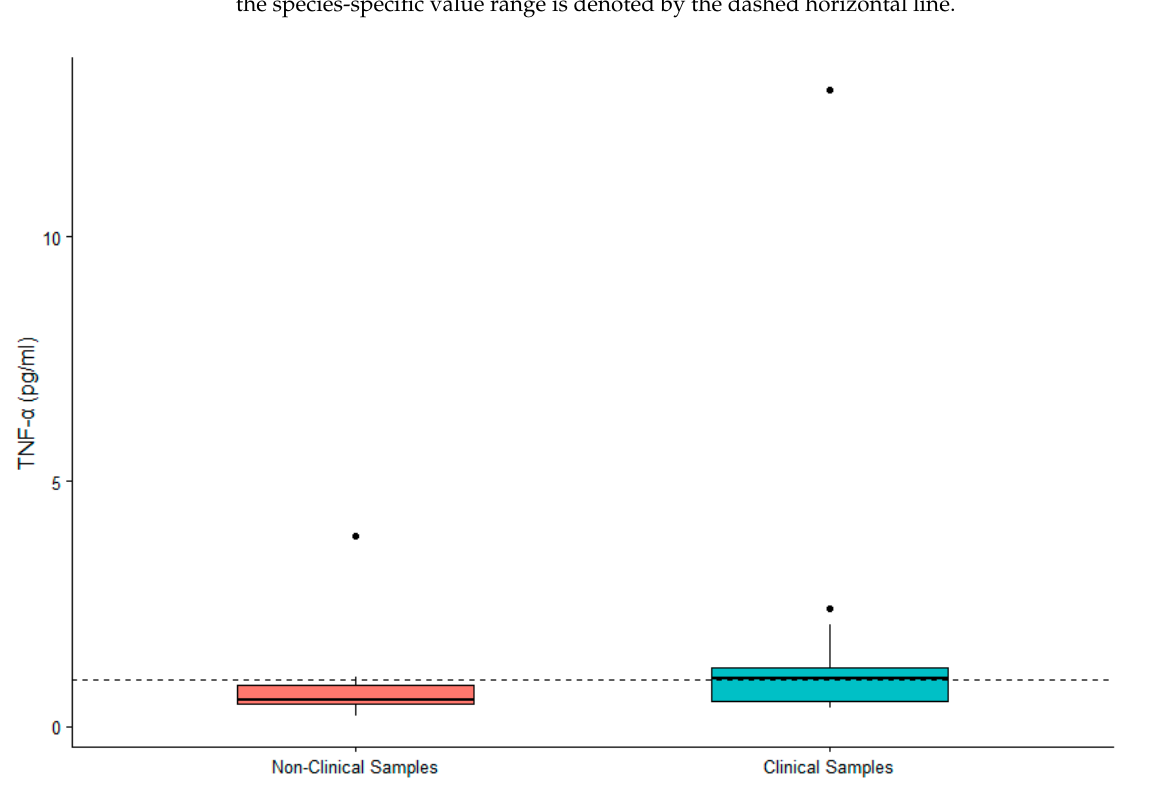
Figure 3. Differences in concentrations of serum TNF ‐α between non ‐ clinical and clinical western lowland gorilla ( n = 21) samples ( β = − 0.461, SE = 0.175, p = 0.008). The calculated upper limit of the species ‐ specific value range is denoted by the dashed horizontal line.